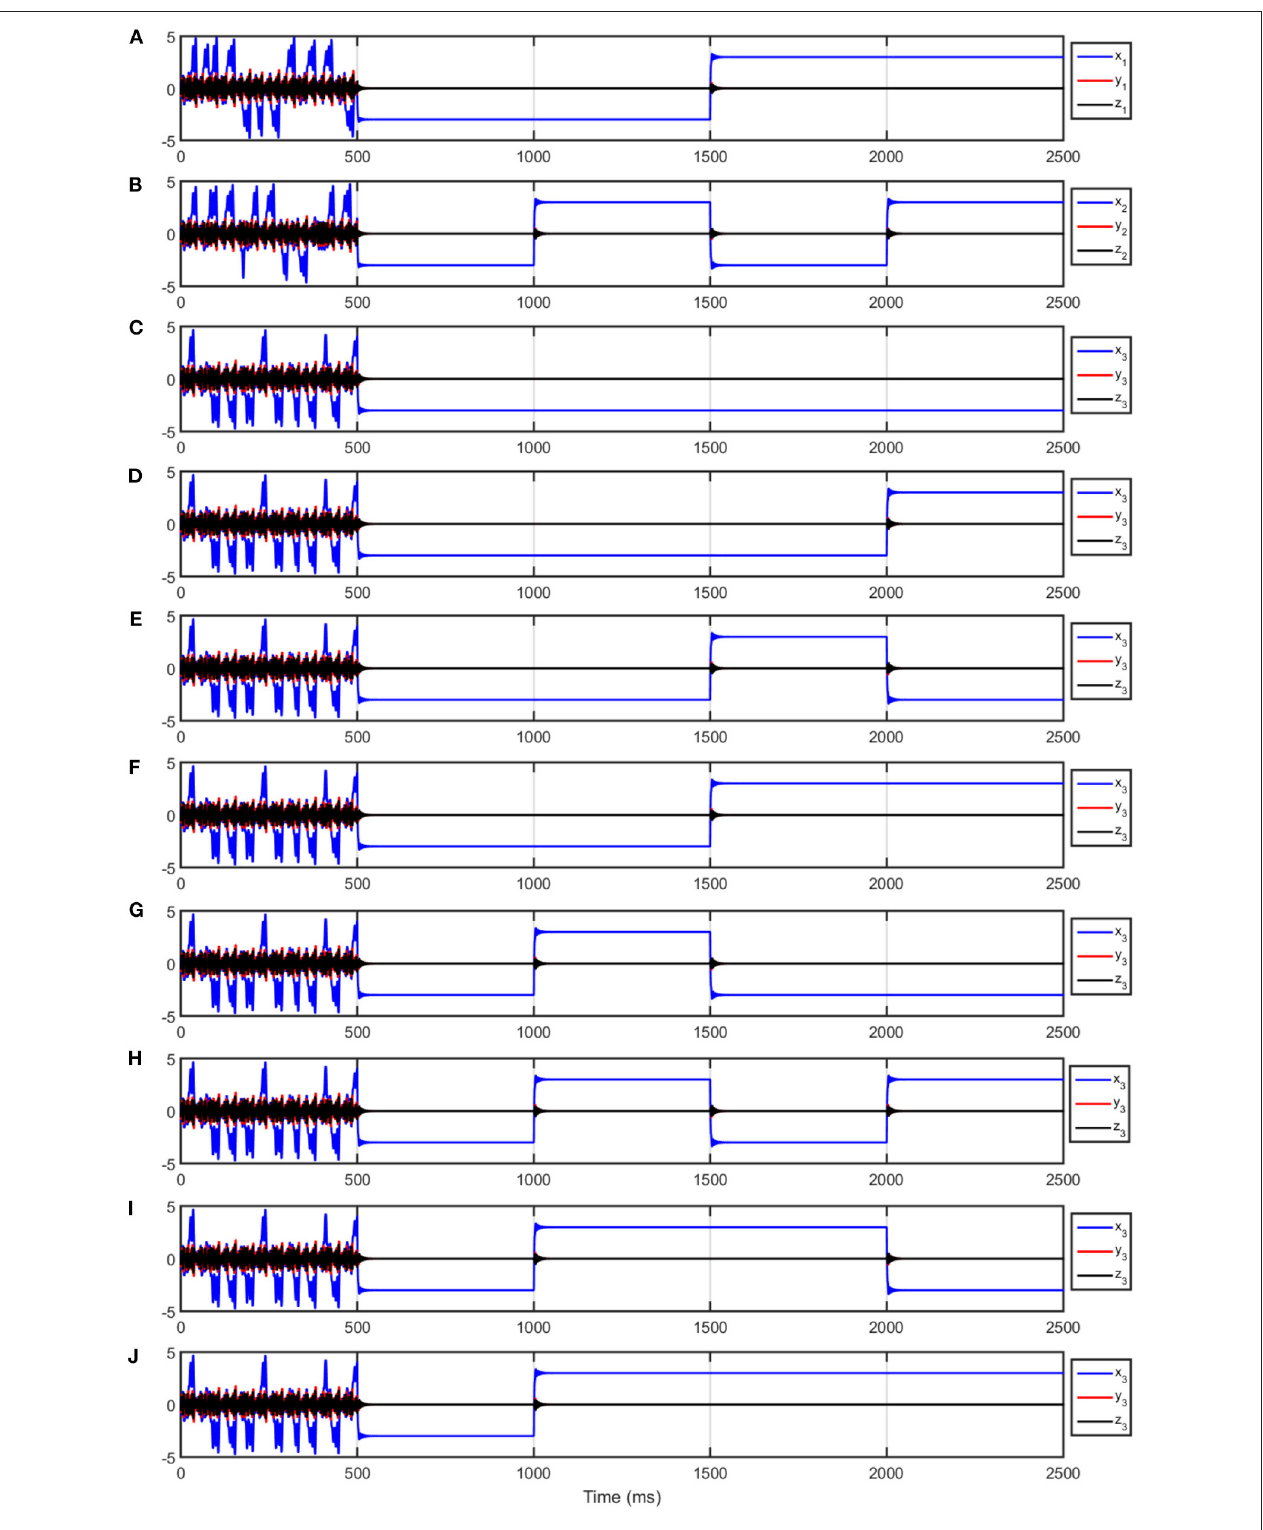
FIGURE 5 | Temporal evolution of the input nodes and for the output node emulating the logic functions shown in the upper part of Table Truth Tables. The plot in (A) corresponds to the input node 1. Plot (B) corresponds to the temporal evolution of input node 2. bot is represented in plot (C) ; I 1 I 2 in plot (D) ; I 1 I 2 ’ in plot (E) ; I 1 in plot (F) ; I 1 ’I 2 in plot (G) ; I 2 in plot (H) ; I 1 plus I 2 in plot (I) ; I 1 +I 2 in plot (J)